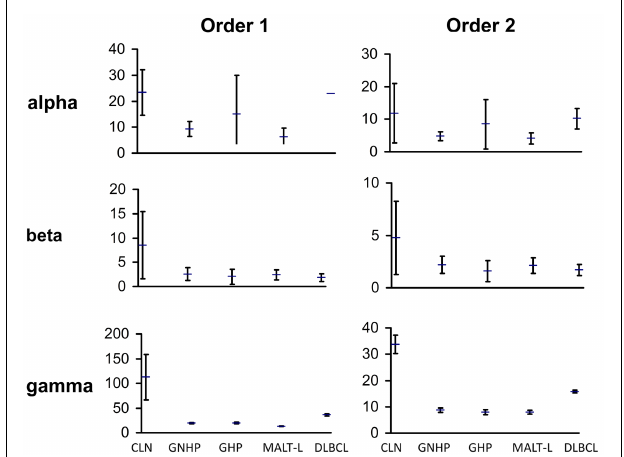
FIGURE 1 | Graphic presentation of alpha, beta, and gamma diversity indices of order 1 and 2 . Diversity measures were calculated, as described in the Section “Materials and Methods,” based on the Shannon entropy and the Simpson concentration diversity indices.The alpha diversity measure represents the average sample diversity in each condition/population.The gamma diversity measure represents the “global” repertoire diversity across all samples studied in each condition/population. The beta diversity measure represents the diversity component resulting from the variability between samples. In our Ig gene repertoire studies, the abundance data (numbers of unique sequences) of antibody clones in each sample was used to estimate the mean, standard error, and 95% confidence intervals (CI) of the total number of unique sequences in clones within each sample.The CI allows us to compare between diversity indices of different conditions.The error bars show the standard